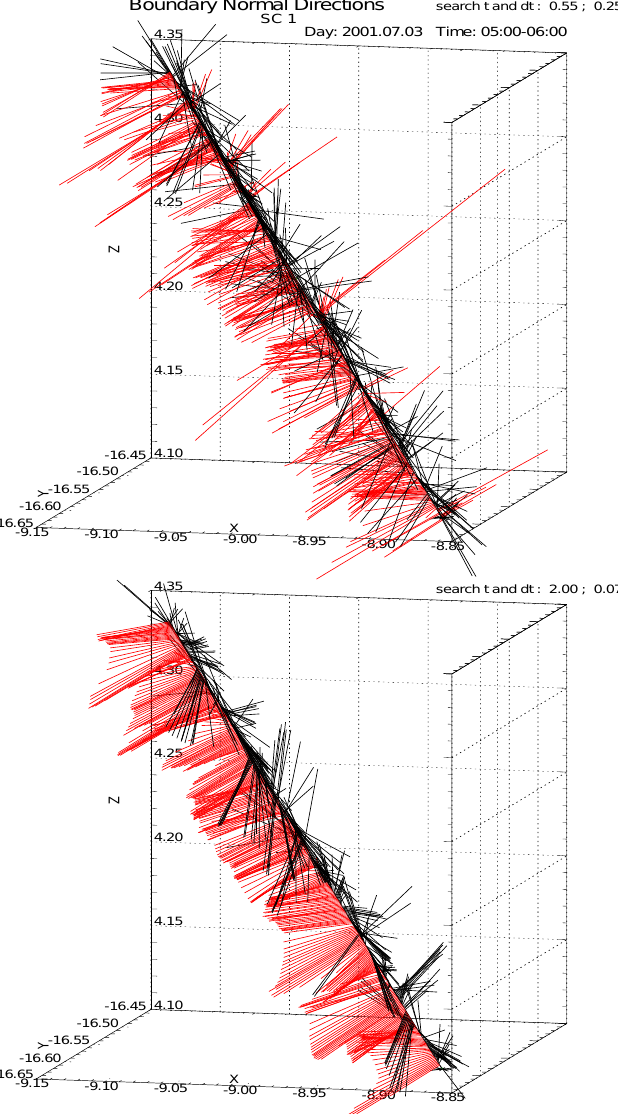
Fig. 6. Sc1 observations between 05:00–06:00 UT of the boundary normal vectors (black) and deHoffman Teller frame vectors (red) along spacecraft trajectory when using 0.55min nested intervals (top) and 2min nested intervals (bottom). The view is along the average normal direction, such that the black vectors indicate a de- viation from the average normal. Equivalent plots for sc3 and sc4 show similar type of behaviour of the boundary normals and de- Hoffman Teller frame